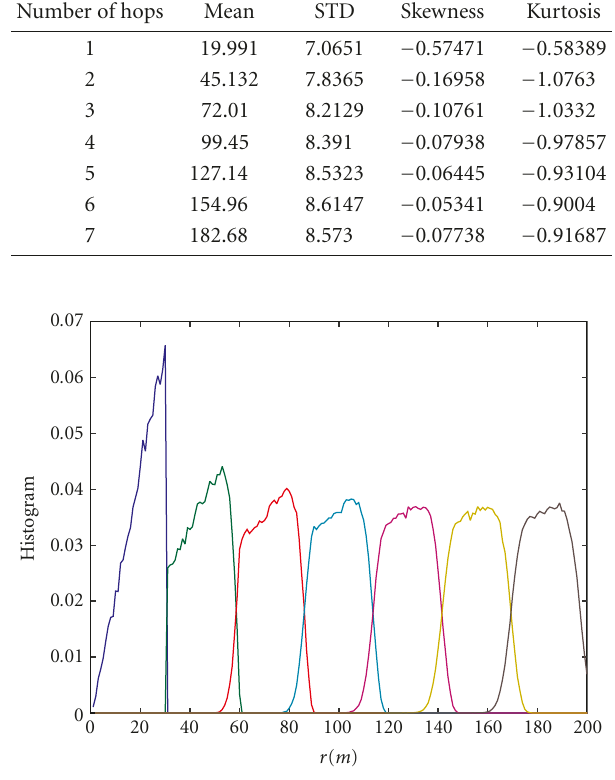
Figure 1: Histograms of hop-distance joint distribution ( N = 1000, R Bound = 200, R =